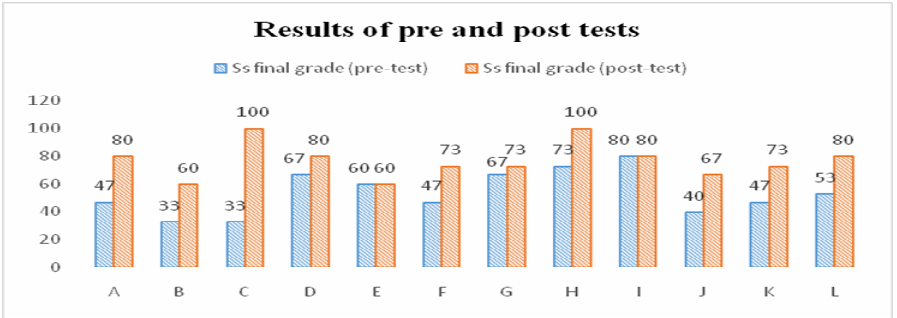
Figure 2. Final results of pre and post-tests N=12